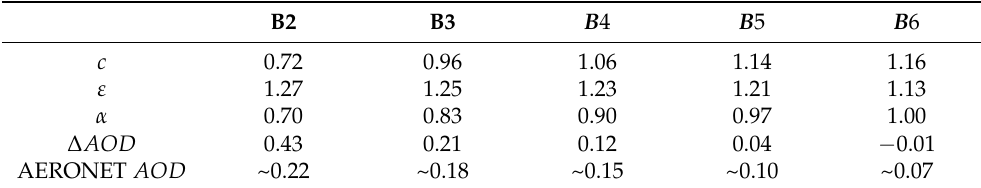
Table 5. Estimation of spectral dependence of the aerosol optical depth according to Equation (32) for sample scene BRS-3. See text for further